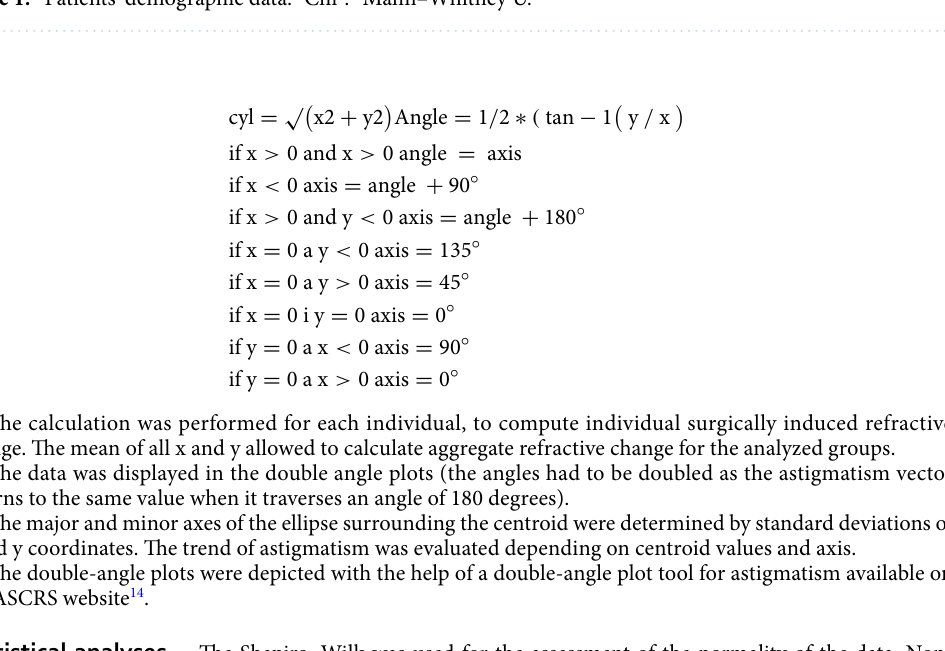
Table 1. Patients’ demographic data. * Chi 2 . # Mann–Whitney